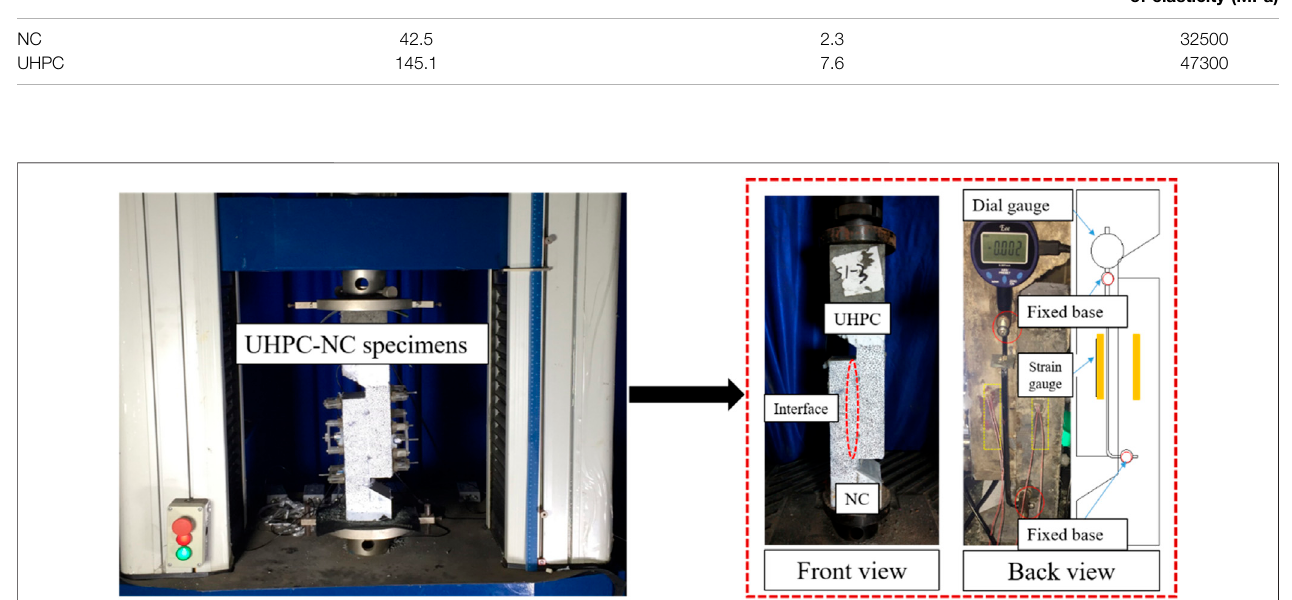
FIGURE 2 | Loading